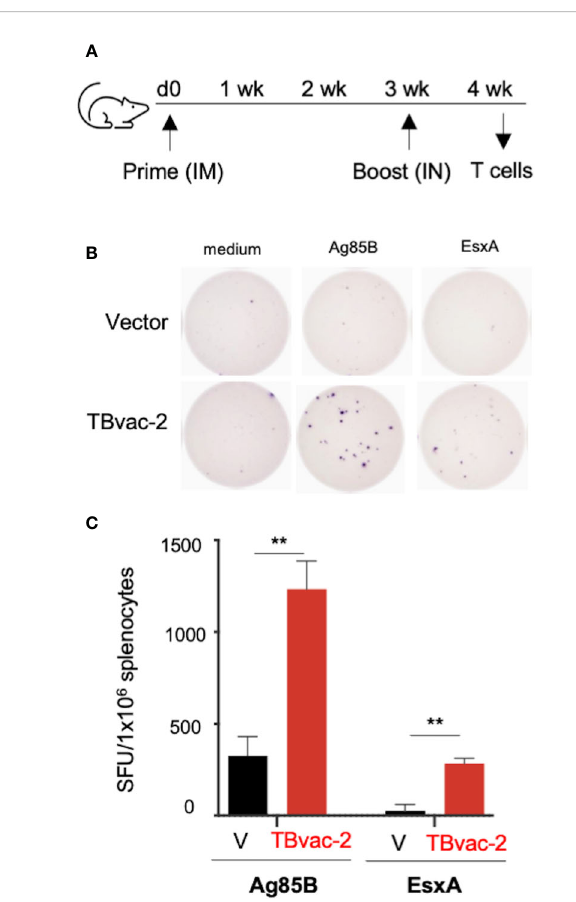
FIGURE 2 Evaluation of TBvac2-induced T cell responses by ELISpot assay. (A) BL6 mice (N=3) were primed with 1x10 5 PFU of rP18tri viral vector (V) alone or TBvac-2 through the IM route, and 21 days later boosted with the same virus at the same dose through the IN route. At 7 d post-boost (dpb), splenocytes were isolated and incubated with medium alone or peptide pools of Ag85B or ESAT-6/EsxA, followed by detection of mouse IFN g by ELISpot. (B) Representative ELISpot wells. (C) The number of IFN g - secreting cells per million splenocytes in the vector and TBvac-2- immunized mice after Ag85B or ESAT-6/EsxA peptide stimulation was normalized with medium-alone control and shown as the average with standard deviation. Statistical analysis was conducted with unpaired t-test. **p <